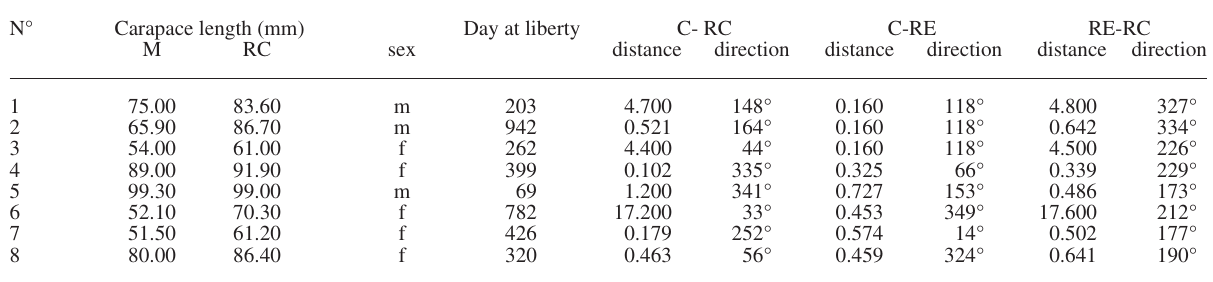
Table 1. – length increments, sex, days at liberty and movements [distance (km) and direction] of eight lobsters tagged and release during the experimentation. M, tagging; rC, recapture; C, point of initial site of capture; re, point of release; rC, point of recapture.